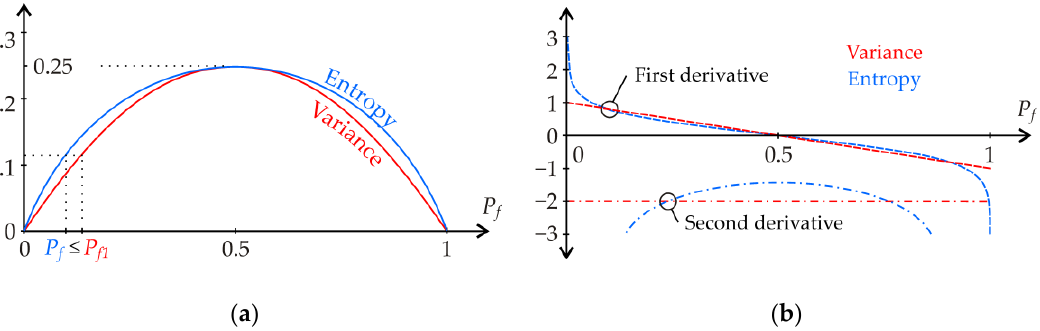
Figure 4. Sensitivity measures based on entropy and variance: ( a ) entropy and variance functions; ( b ) graph of derivatives of functions.